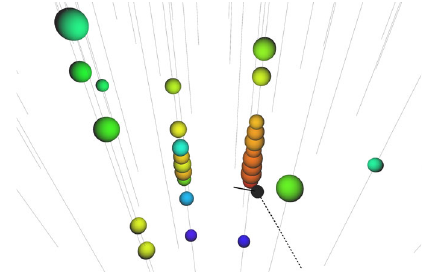
Fig. 2 Example event displays: The size of spheres represent the amount of light observed in each DOM; larger spheres correspond to more light observed. The dotted black line represents the incoming neu- trino, the black circle the cascade, and the solid black line the outgoing muon track. The size of the black round marker is proportional to the energy of the cascade at the vertex. The color represents the timing of the hit, where the earliest hits are colored in red and the latest hits in blue. Low energy events have significantly fewer hits [18]